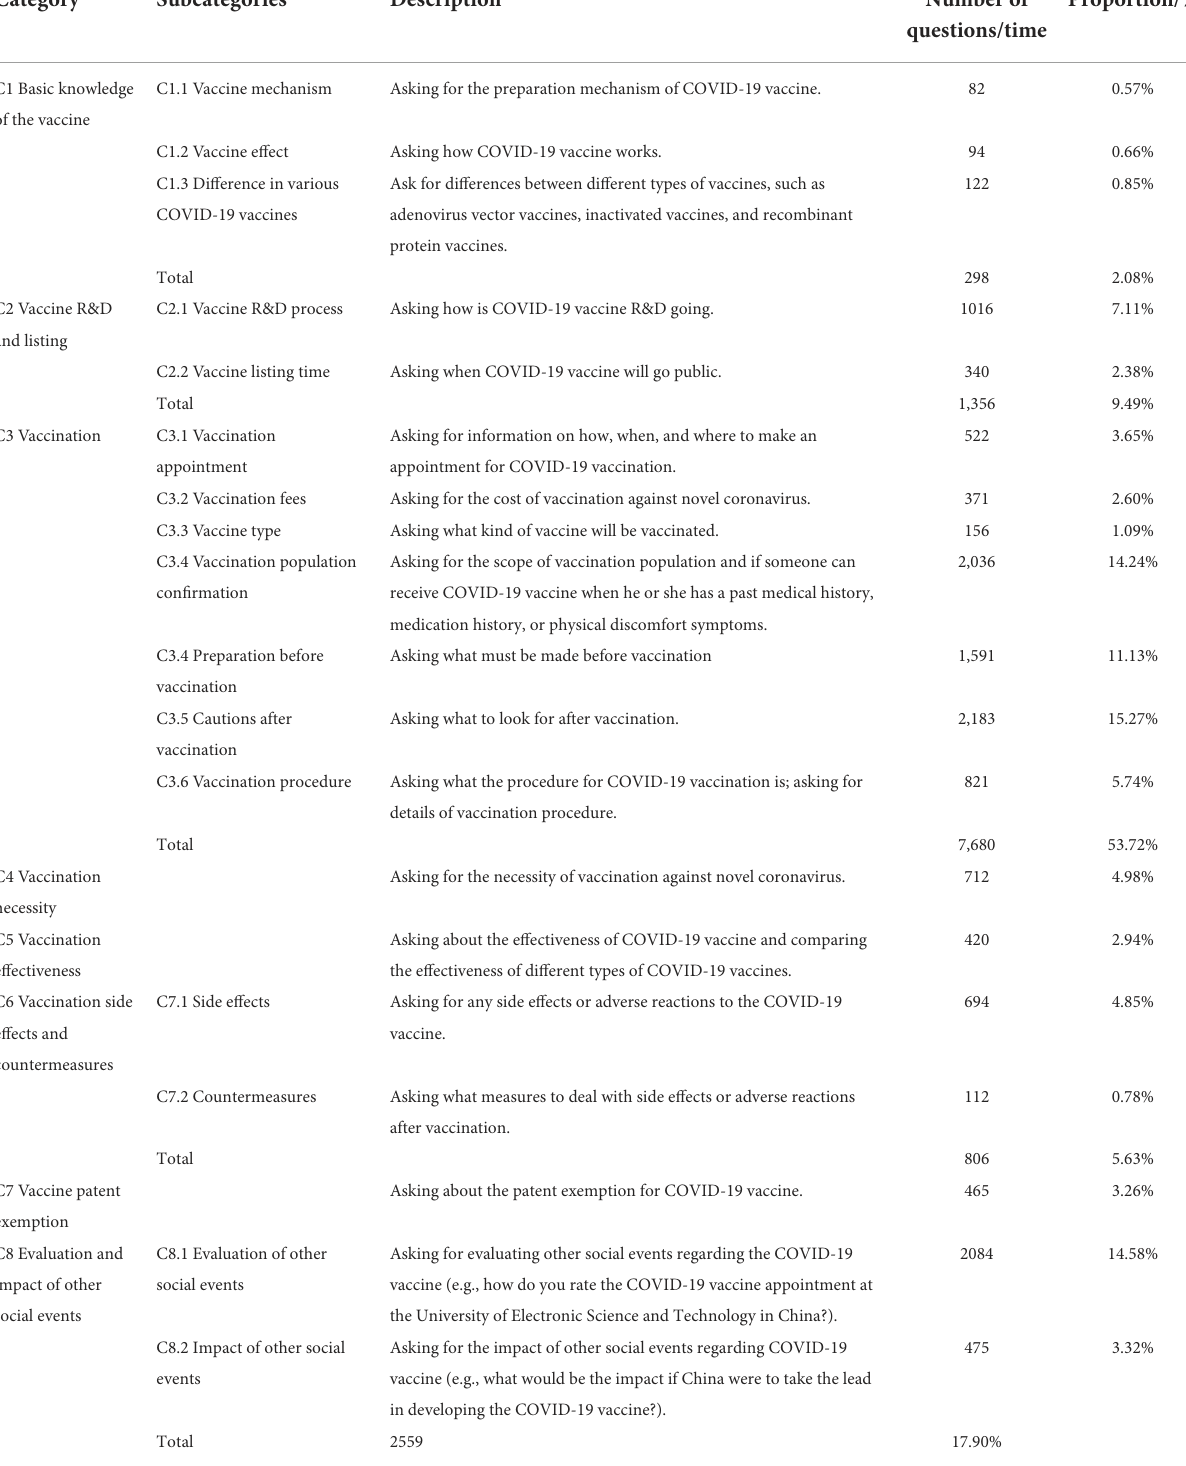
TABLE 4 The public COVID-19 vaccine information needs a